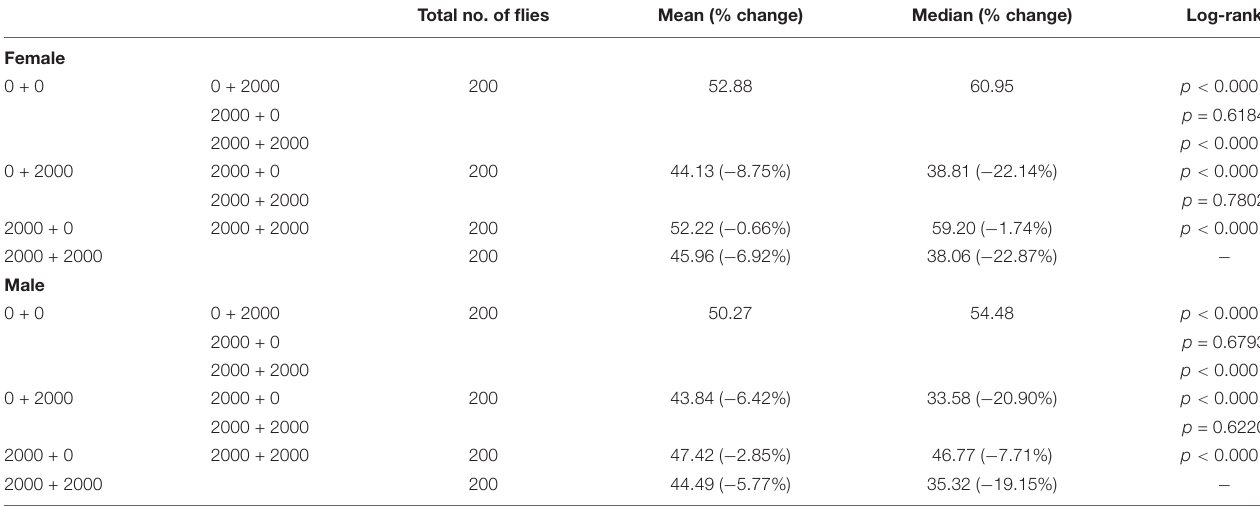
TABLE 1 | Statistics for survival